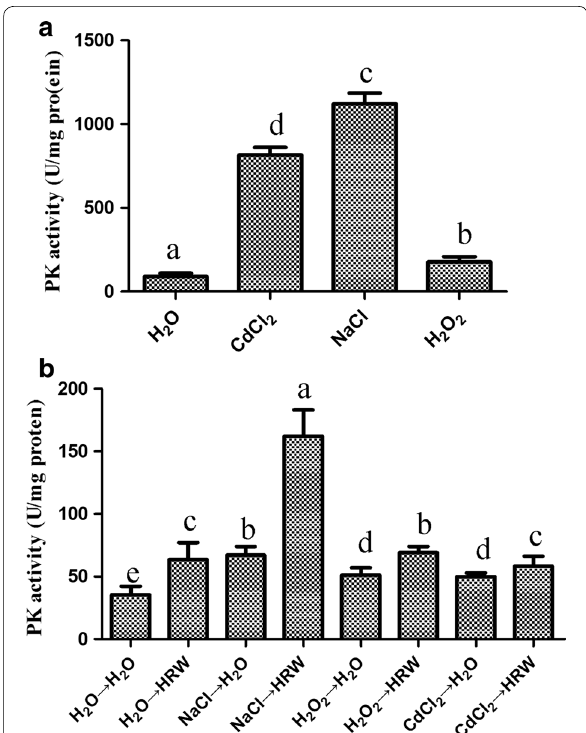
Fig. 6 Effects of HRW treatment on PK activity in the mycelia of Hypsizygus marmoreus . The PK activity was determined in the mycelia pretreated with CdCl 2 , NaCl or H 2 O 2 ( a ) and then treated with HRW for 48 h ( b ). Data are mean SE from three independent experi- ± ments. Bars with different letters are significantly different at P < 0.05 according to Duncan’s multiple range